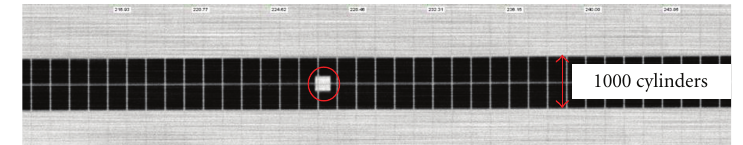
Figure 4: OSA image of media surface near the error location.